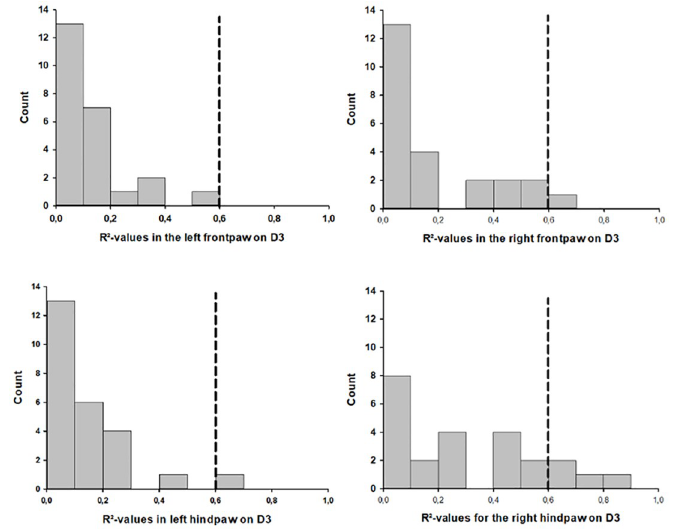
Fig 8. Distribution on R 2 -values for all four single paws on day three after